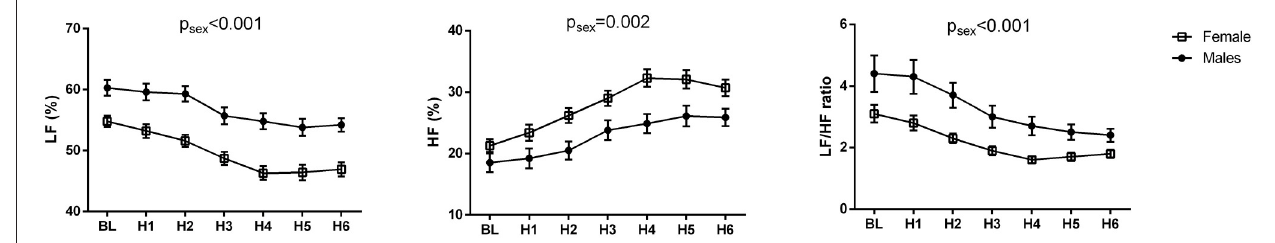
FIGURE 3 | Change of frequency domain parameters in male and female patients after fingolimod administration. BL, baseline; H1, H2, H3, H4, H5, H6, the first, second, third, fourth, fifth, and sixth hour after fingolimod intake; HF, relative value of high frequency power; LF, relative value of low frequency power. Values are presented as mean ± SEM. p sex , the significance of sex as a main effect.